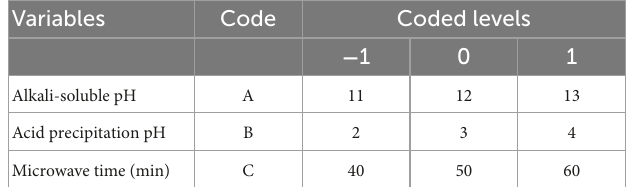
TABLE 1 Factors and levels of independent variables used for the Box–Behnken experimental design.